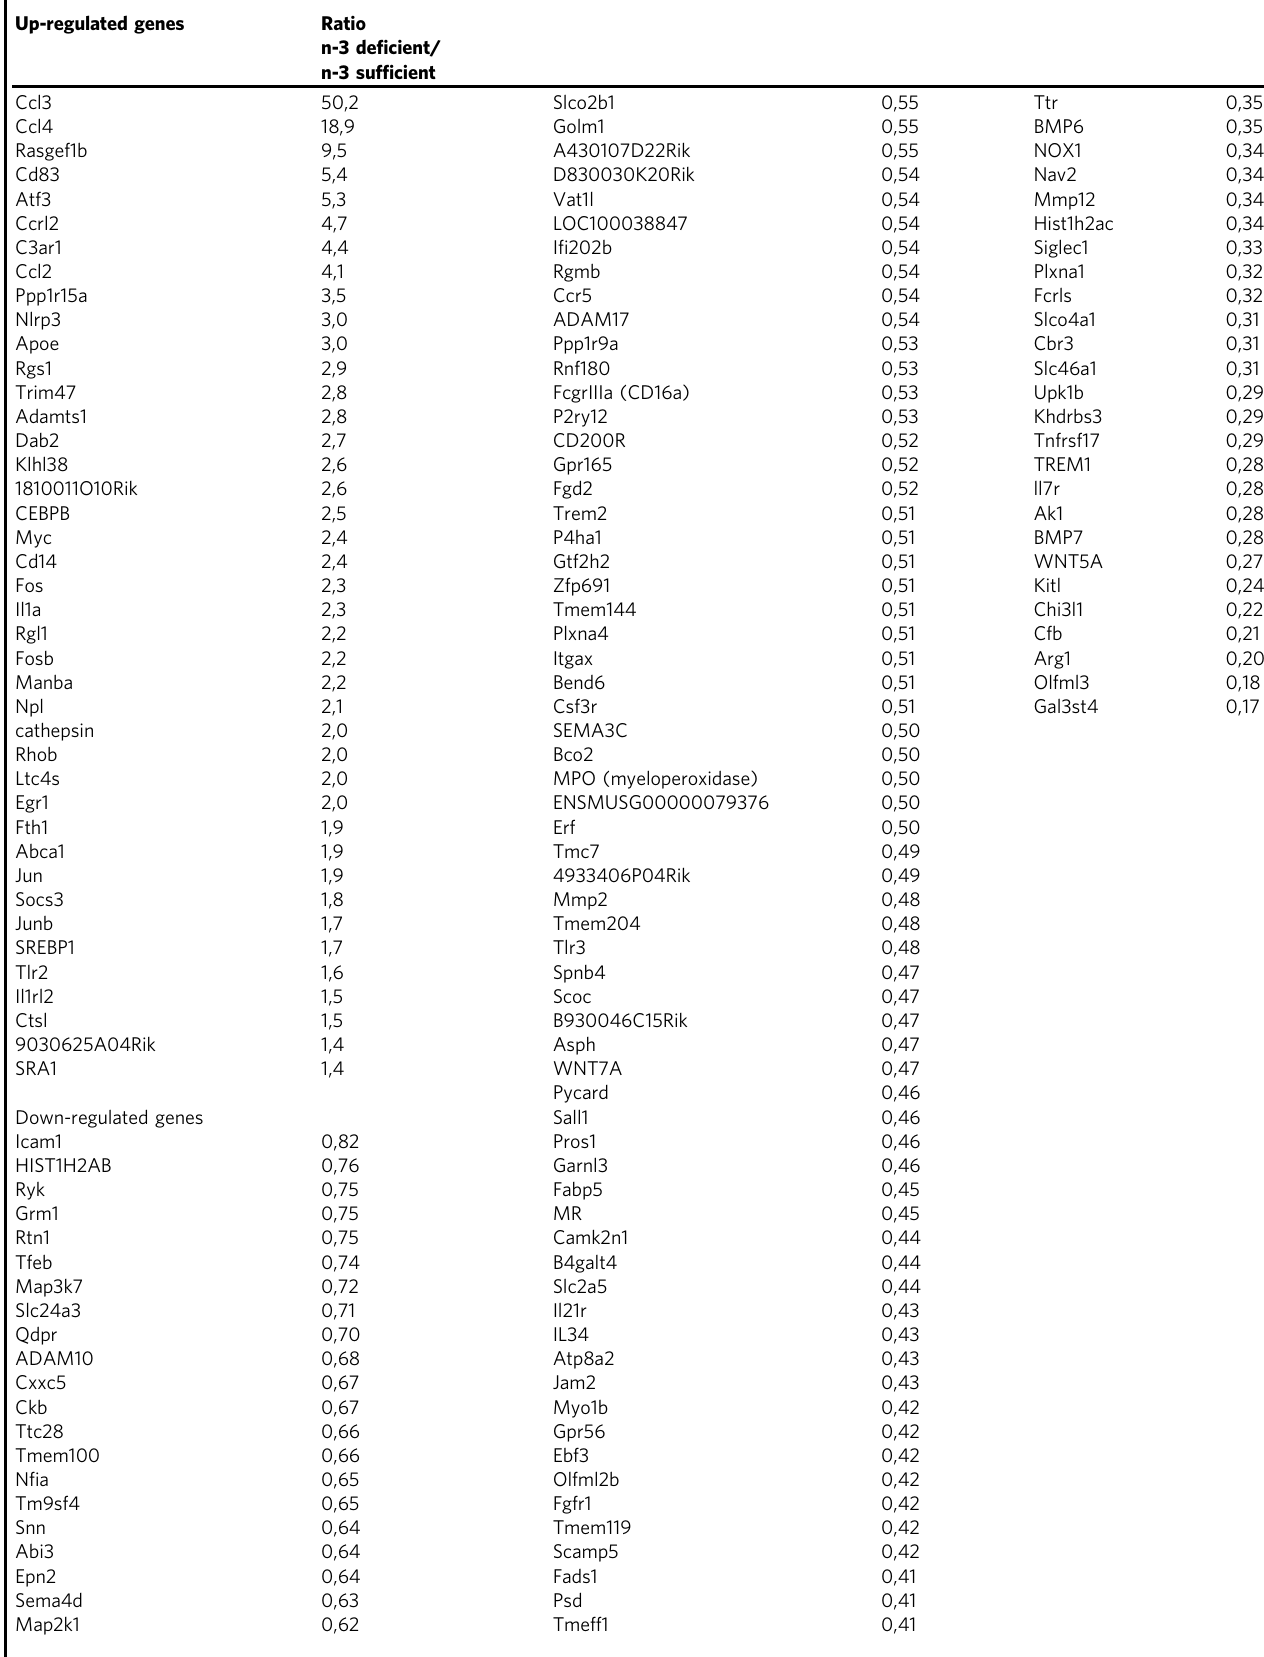
Table 3 List of all genes that are signi fi cantly modulated by maternal n-3 PUFA de fi ciency. Up-regulated